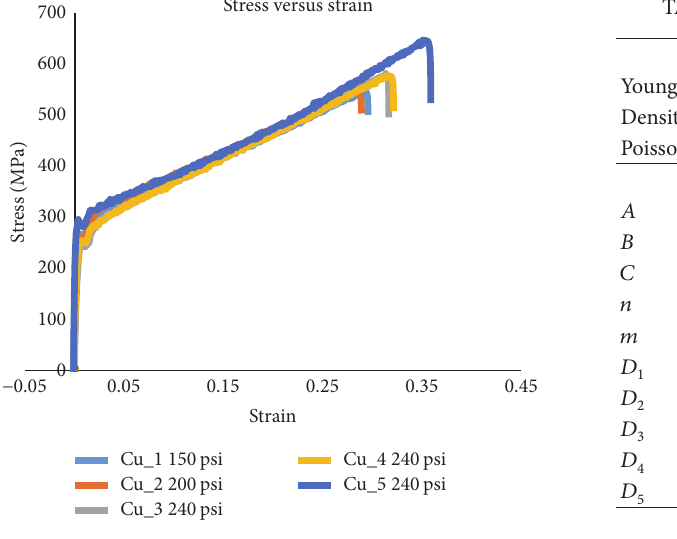
Figure 1: Stress-strain curves of aluminum under different pres- sures.